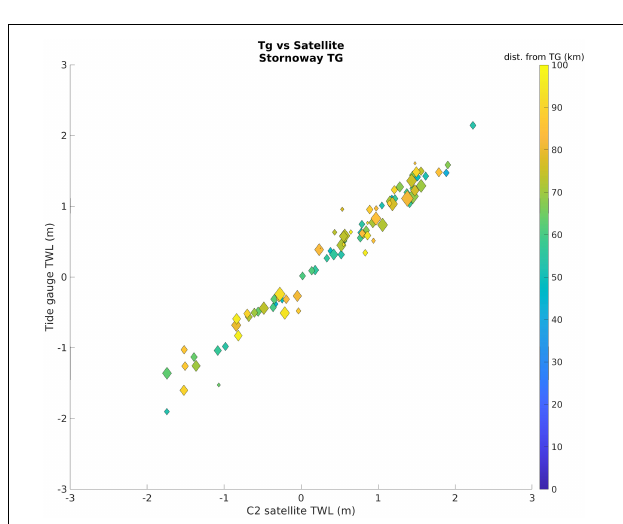
FIGURE 4 | Comparison of C2 with TG at Stornoway, which had the lowest error of all stations considered. The color shows the distance of the Satellite from the TG (blue is at the TG location; yellow is up to 100 km away from the TG). The marker size indicates the distance of the satellite from the coast (The smallest markers are within 1 km of the coast, the widest markers are up to 50 km from the coast). Note that the distance of the satellite from the TG has a smaller impact than the distance to the coast over the